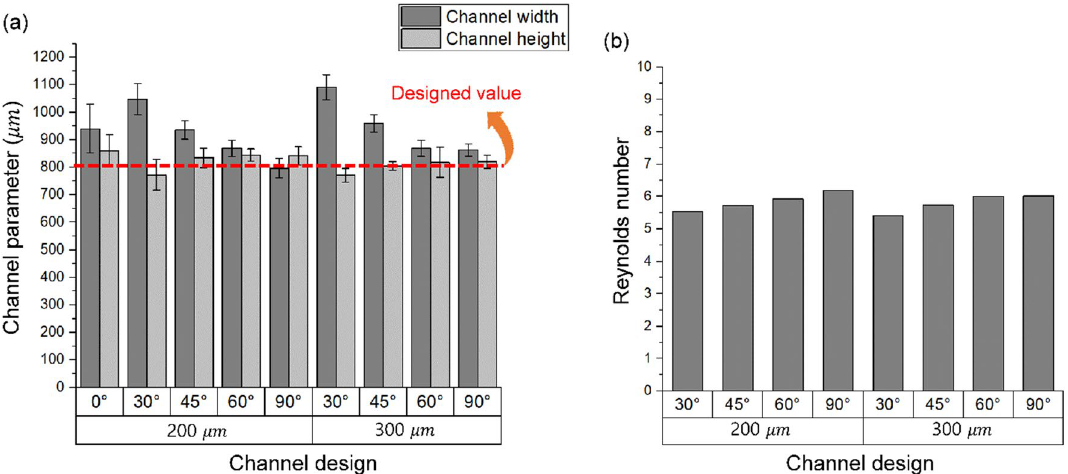
Figure 4. Characteristic of the fabricated mixing channel: ( a ) dimensions of mixing channel molds, ( b ) Reynolds number of the mixing channel with a flow rate of 120 μL/min at each different printing angles were set to 30, 45, 60, and 90°, and two different printing resolutions of 200 and 300 μm were utilized, as shown in Fig. 3. As the printing resolution increased from 200 to 300 μm, larger patterns were generated, and the cross-sectional area of the mixing channel increased simultaneously. It was also noticeable that the angle of inclination of each pattern was almost identical to the printing (raster) angle (see Fig. 1), leading to the facile design of inclined groove patterns in micro mixing channels. The measured dimensions (width and height) of the printed channel molds are shown in Fig. 4a. To evalu- ate the precision and accuracy of manufacturing technique, five different molds for each channel design were used, and the width and height at 10 different locations per each mold were measured. In the CAD file of the 3D printing model, a cylinder with a diameter of 800 μm was designed; however, a relative difference existed in the channel width along the channel height in the printed molds. This phenomenon occurred because the more oblique printing angle and the higher resolution had a smaller area where the printed upper disc shapes were supported. Consequently, the difference in channel width between the designed and manufactured dimensions becomes larger as the printing angle decreases from 90 to 30° and the printing resolution decreases from 200 to 300 μm. Although the dimensions of the mixing channels slightly differed, the Reynolds number calculated by considering the cross-sectional area of each mixing channel showed a similar range between 5.4 and 6.1 under a flow rate of 120 μL/min at the inlet, as shown in Fig. 4b. Therefore, the change in flow behavior and mixing efficiency owing to the channel dimensions were relatively negligible in this study. To analyze the fluid behavior in the mixing channel, colorimetric experiments were conducted using water with color (blue and yellow) dyes; the results are shown in Fig. 5. The applied flow rate for each inlet was set to 120 μL/min, and the total length of all the mixing channels was 35 mm. As expected, the two fluids were not mixed in the mixing channel printed with a printing angle of 0° (i.e., straight channel without surface patterns). However, the two fluids exhibited distinct behaviors as the surface patterns varied in the mixing channels. For the mixing channel cast from the mold printed with an angle of 90° (i.e., channel marked as “90°–200 μm” and “90°–300 μm” in Fig. 5), two fluids flowed in a straight flow direction. The green area, which indicates the fluid containing mixed blue and yellow water, was thicker in the case of “90°–300 μm” than in the case of “90°–200 μm”, indicating that the surface pattern affected the mixing behavior in the micromixer. Although the green area appeared slightly at the end of the mixing channel, a large portion of unmixed blue and yellow water still existed in the mixing channel, resulting from insufficient mixing performance in mixing channels with 90°-patterns. In contrast, it was observed that the blue water started penetrating the flow of yellow water at the raster (pattern) angle of 60° (see “60°–200 μm” and “60°–300 μm” cases in Fig. 5). Furthermore, as the raster angle of patterns and printing resolution (i.e., pattern thickness) were more oblique and thicker, the mixing of the two fluids became stronger. It should be noted that the position where the two fluids started mixing, resulting in green color, gradually approached the inlet location (see the case of “30°–300 μm”). This implies that the two fluids immediately start mixing in the mixing channel when the angles of the surface pattern and thickness were 30° and 300 μm, respectively. Although the different quality of the joining part could cause the early or delayed mix- ing, the inclined angle and thickness of the surface pattern might significantly attribute to the mixing behavior rather than the quality of the joining part. Computational fluid dynamics (CFD) was performed to investigate in greater depth the flow behavior and mixing principle in the mixing channel. The CAD modeling for CFD analysis was redesigned using the measured dimensional parameters shown in Fig. 4a, as indicated in Fig. S1 in Supplementary Material. The shape of mesh, mesh grid dependency, and simulation results are shown in Table S1 and Figs. S2–S5 in Supplementary Material. Figure 6 shows the comparison between the simulation and the colorimetric experiment in the mixing channel of “30°–300 μm”. The flow color indicates the concentration of the fluid. The red and blue colors correspond to a concentration of 1 and − 1, respectively, and change to a green color (concentration of 0) as they mixed properly. In simulation results, the fluid in direct contact with the surface of the mixing channel flowed along the raster